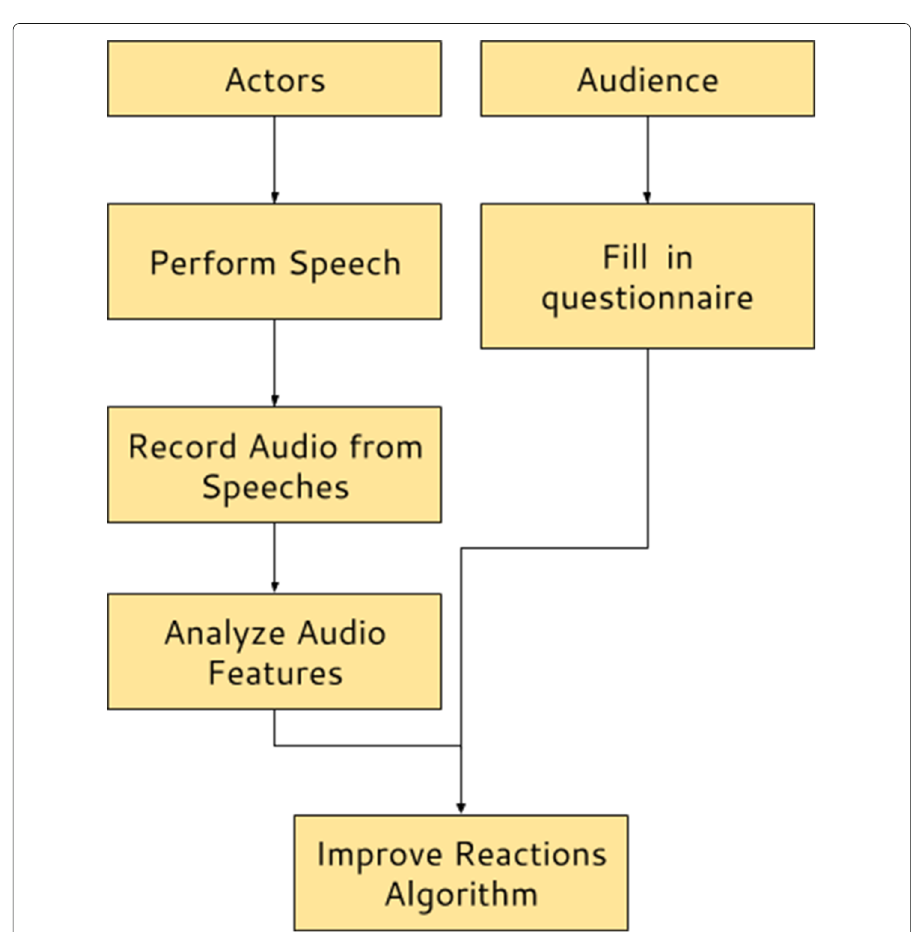
Fig. 3 Experimental design. Diagram of the experimental design